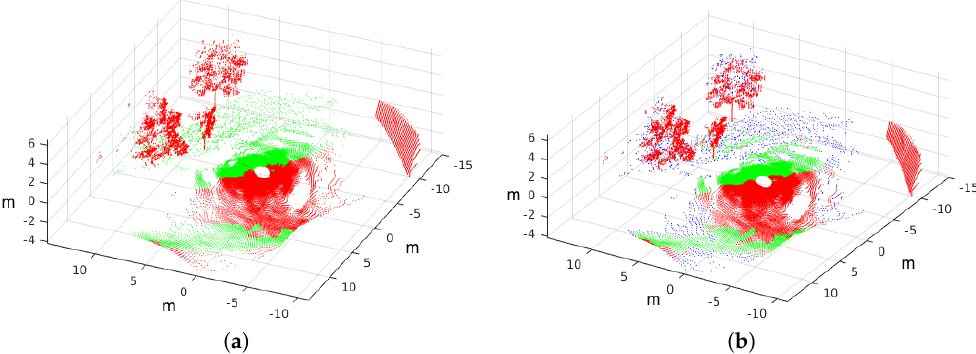
Figure 7. The validation scan near the shore of the lake ( a ) and the prediction results with RF ( b ).